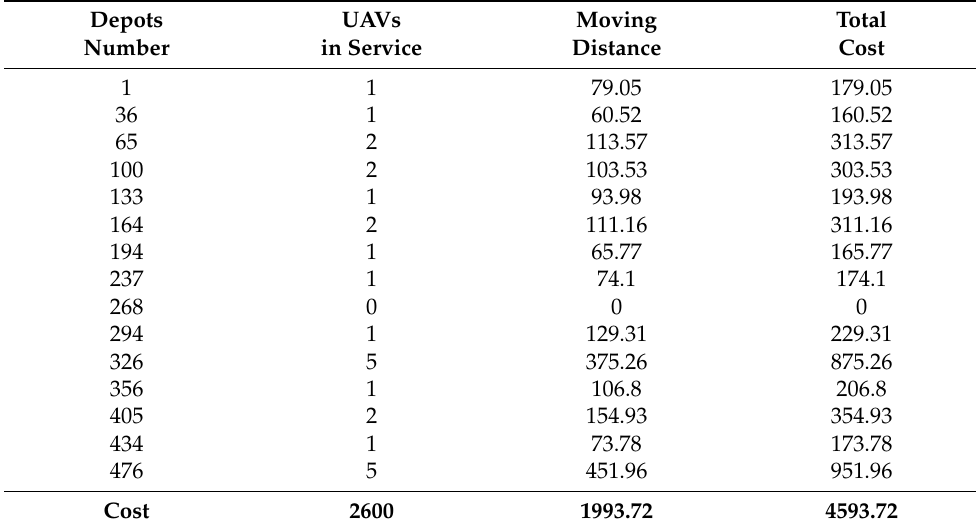
Table 4. Total cost for delivery represented in Figure 8.